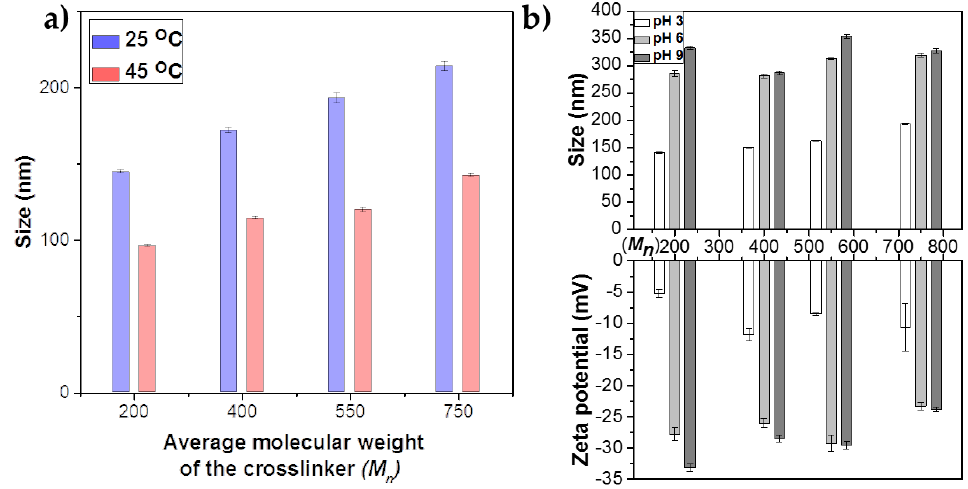
Figure 3. ( a ) Variations in hydrodynamic sizes at 25 and 45 ° C. ( b ) Hydrodynamic sizes and zeta potentials of the nanogels as a function of average molecular weight ( M n ).